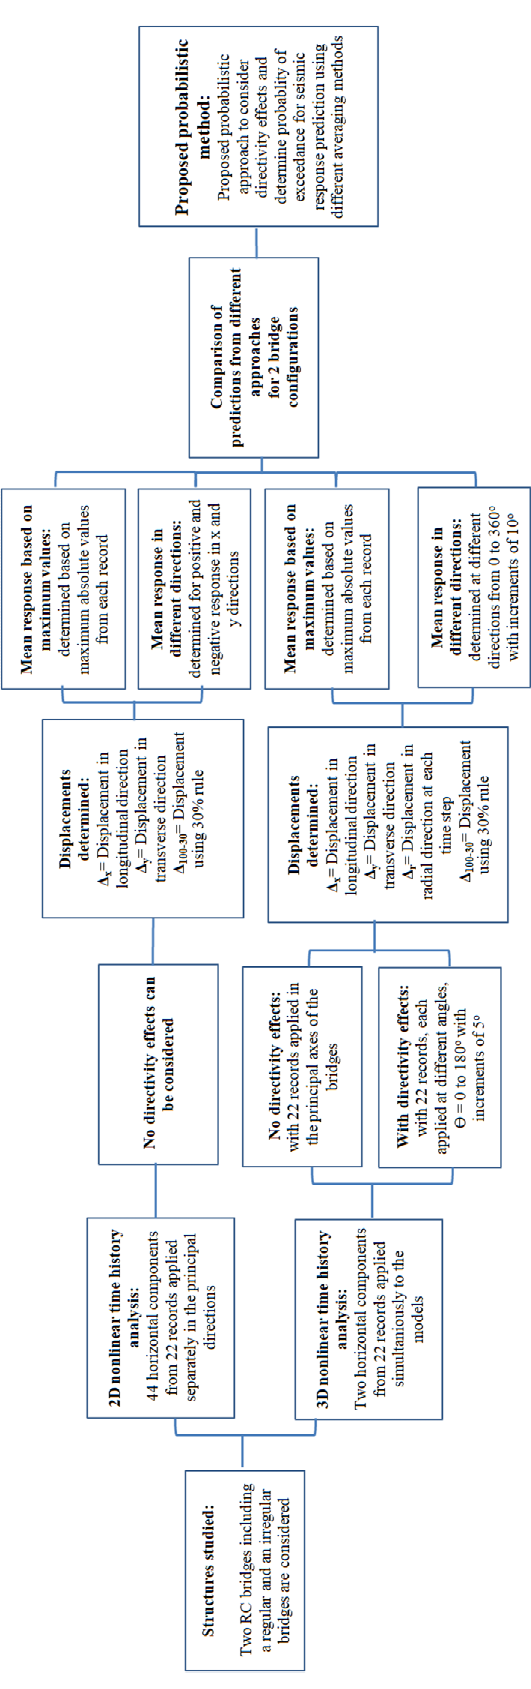
Figure 1. Outline of the study including steps taken and procedure used.